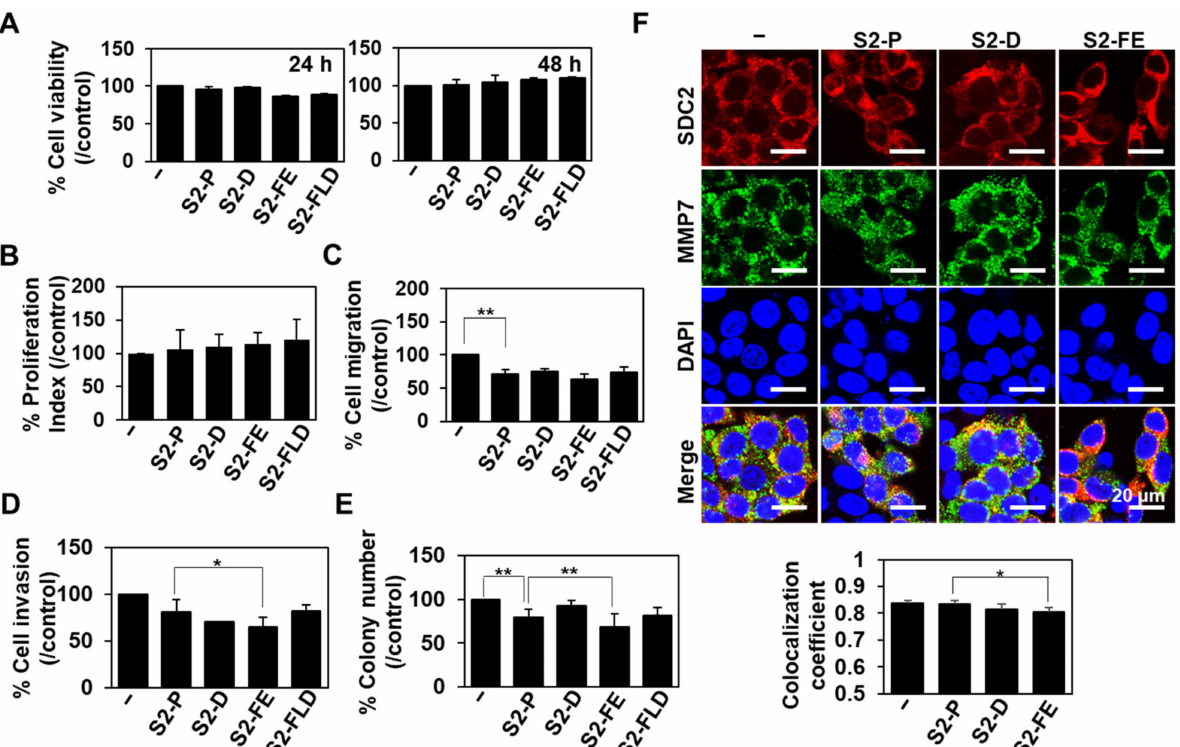
Figure 5. The synthetic peptides inhibited the tumorigenic activity of HCT116 cells. ( A ) The prolifer- ation of HCT116 cells was evaluated with the MTT assay. Data are shown as the average value ± S.D. of three independent experiments carried out in triplicate. ( B ) Cell cycle profiles were obtained by propidium iodine staining and flow cytometry. The proliferation index was calculated as the sum of the number of cells in S phase and G2/M phase. Data are shown as mean ± S.D. ( n = 3). ( C ) Transwell migration assays were performed with HCT116 cells treated with 50 nM of the peptide, with 10% FBS used as a chemoattractant in the lower chamber. Cells (5 × 10 5 ) were allowed to migrate on gelatin- coated (10 µ g/mL) transwell plates for 24 h. Data are shown as mean ± S.D. ( n = 3); **, p < 0.01 versus control. ( D ) For the invasion assay, cells were loaded to the upper compartments of Matrigel-coated (30 µ g/mL) plates, incubated for 24 h, and fixed and stained with 0.6% hematoxylin and 0.5% eosin. The migrated (invaded) cells were counted. Data are shown as mean ± S.D. ( n = 3); *, p < 0.05 versus S2-P. ( E ) HCT116 cells (1 × 10 5 /dish) were seeded in soft-agar plates and allowed to grow for 14 days, and the viable colonies were counted. Data are shown as mean ± S.D. ( n = 3); **, p < 0.01